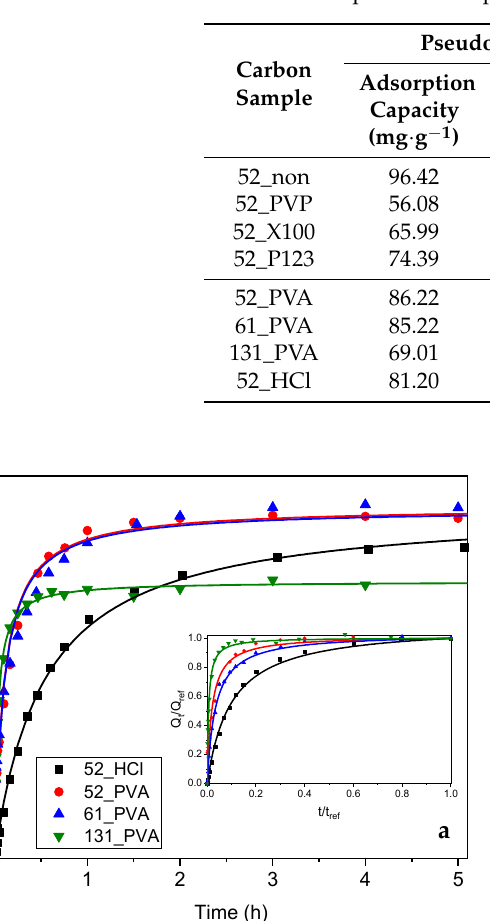
Table 2. Results of fitting the pseudo-first order and pseudo-second order kinetics models to experi-